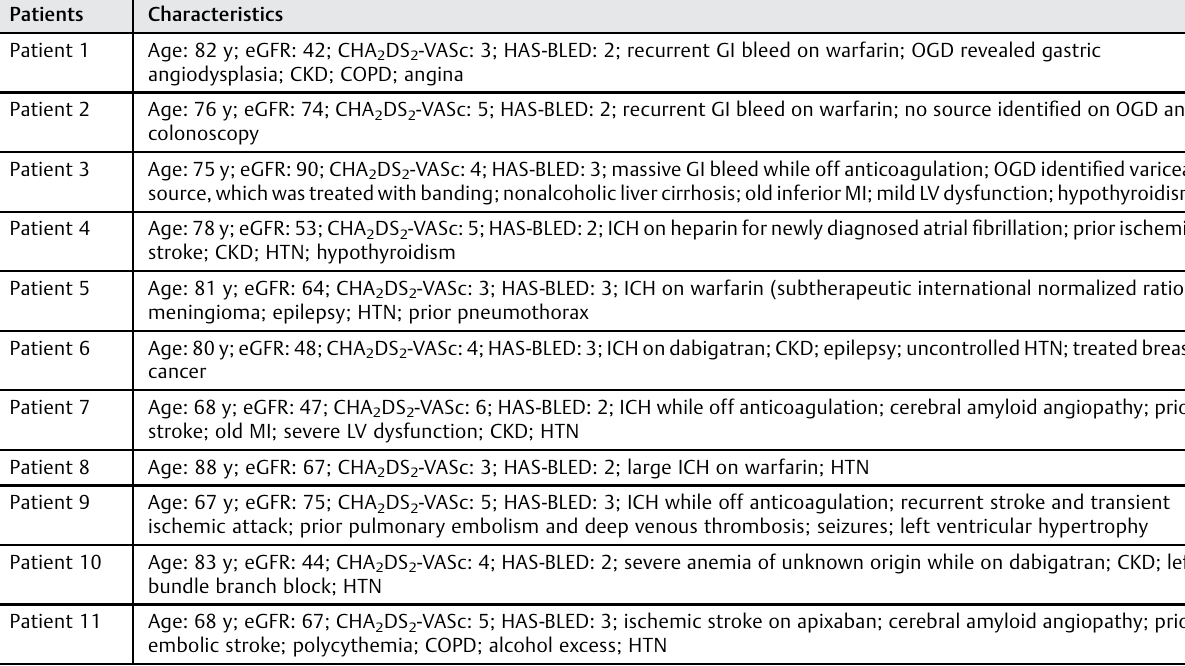
Table 1 Characteristics of patients with left atrial appendage thrombus Patients